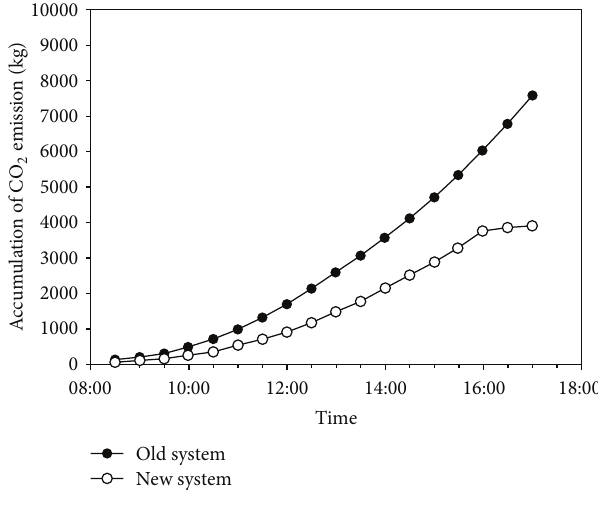
Figure 11: CO 2 emission reductions per